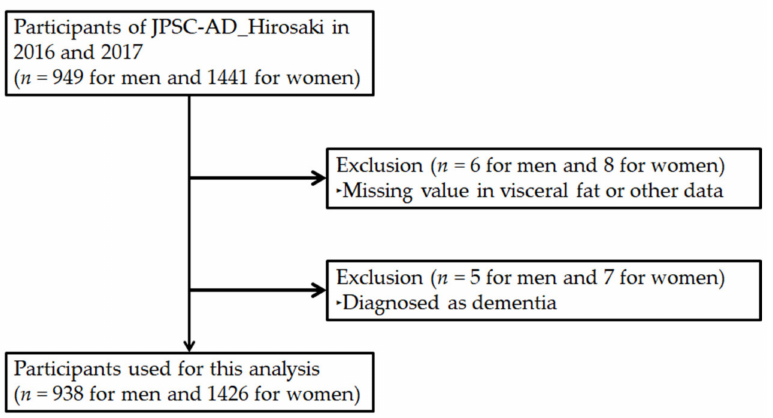
Figure 1. Study flow for selection of the participants. A total of 2364 participants were enrolled in the analysis. JPSC-AD, Japan Prospective Studies Collaboration for Aging and Dementia.